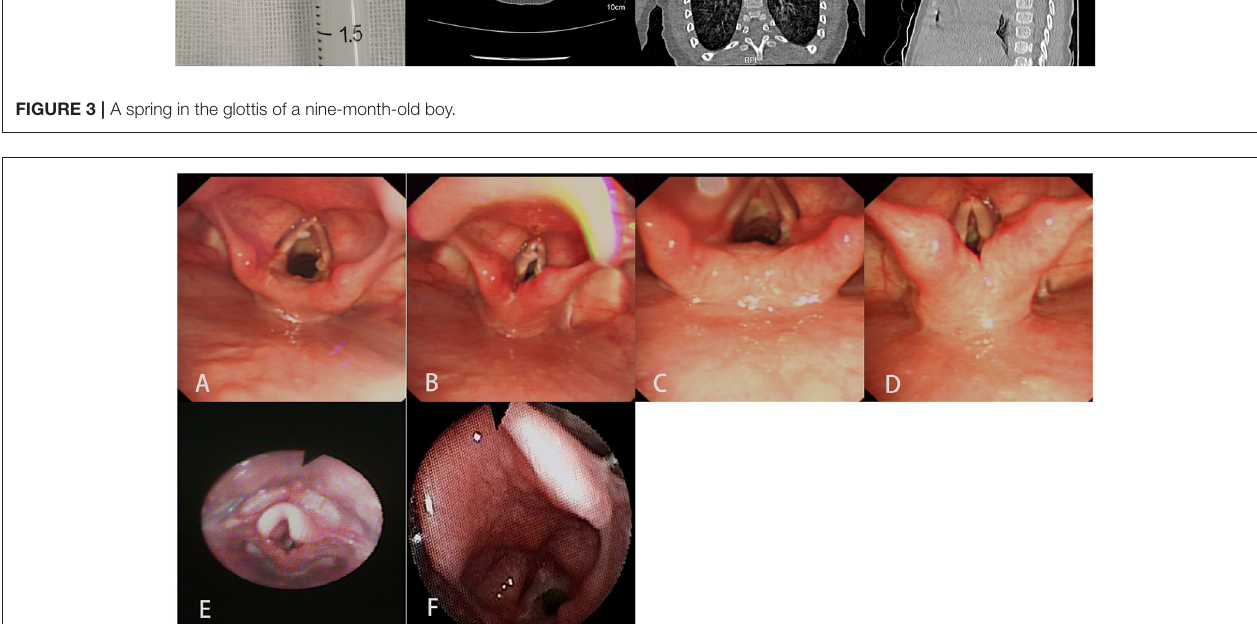
FIGURE 4 | Electronic laryngoscopy showed that there was vocal cord injury in an eight-year-old boy who aspirated a plastic cap of a pen. (A,B) Seven days after rigid bronchoscopy. (C,D) Half month after rigid bronchoscopy. A fiberoptic laryngoscope showed that there was a laryngeal web in a nine-month-old boy who aspirated a spring. (E) Five days after rigid bronchoscopy (without the laryngeal web). (F) Six months after rigid bronchoscopy (with the laryngeal